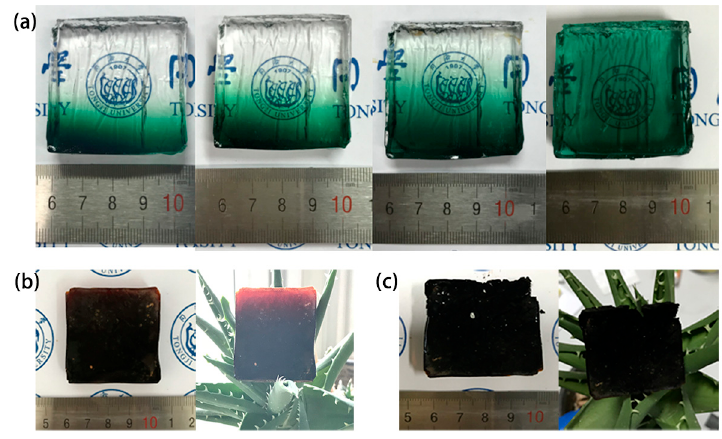
Figure 2. ( a ) The diffusion process of Fe 2+ into the MSQ gel before supercritical fluid drying with the 4 × 4 × 1 cm 3 square mold; The composites aerogel ( b ) after CO 2 supercritical fluid drying and ( c ) after both supercritical fluid drying and thermal treatment.